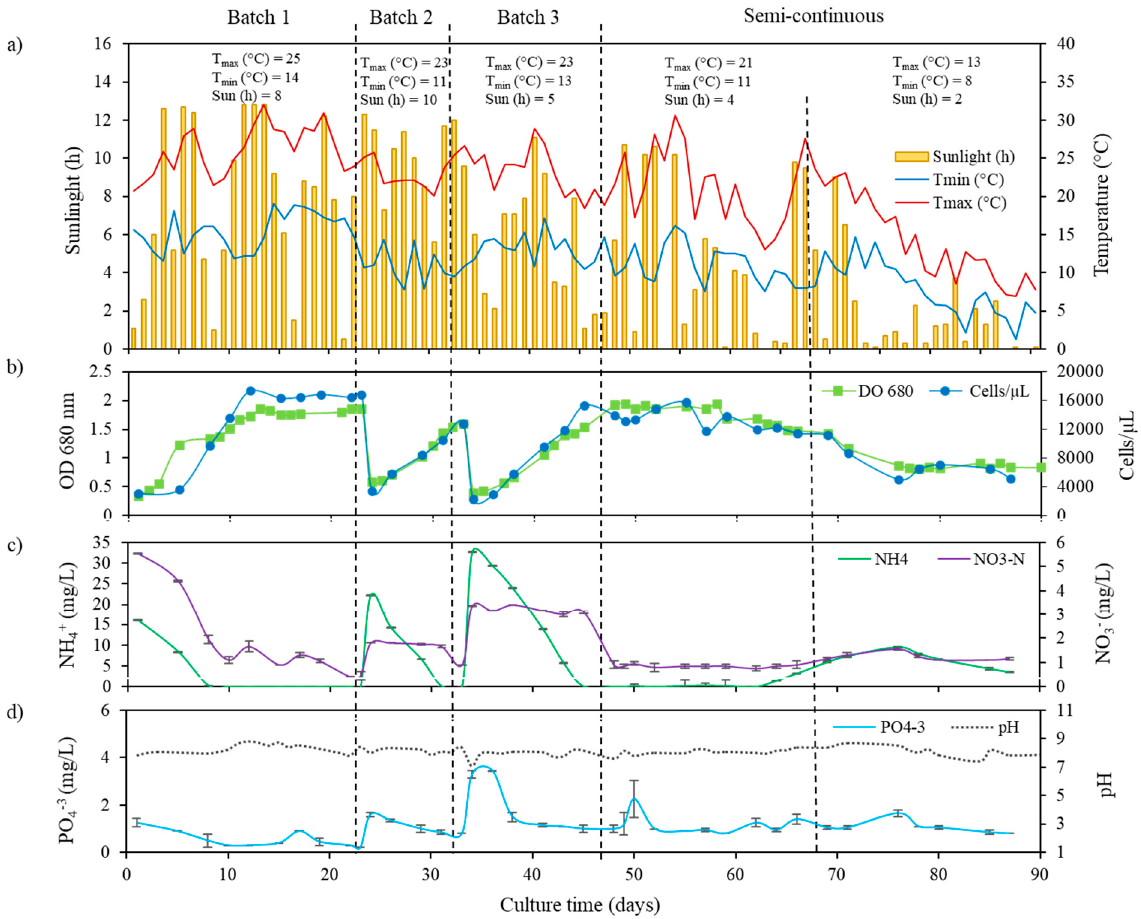
Figure 3. ( a ) Weather condition and temperature data graphs during the running period of the photobioreactor, ( b ) Monoraphidium sp. growth curves in liquid digestate diluted at 1:50, expressed in absorbance at 680 nm and number of cells per µ L, ( c ) NH 4 + and NO 3 − consumption expressed in mg L − 1 , ( d ) pH and PO 43 − consumption expressed in mg L − 1 . Results are presented for